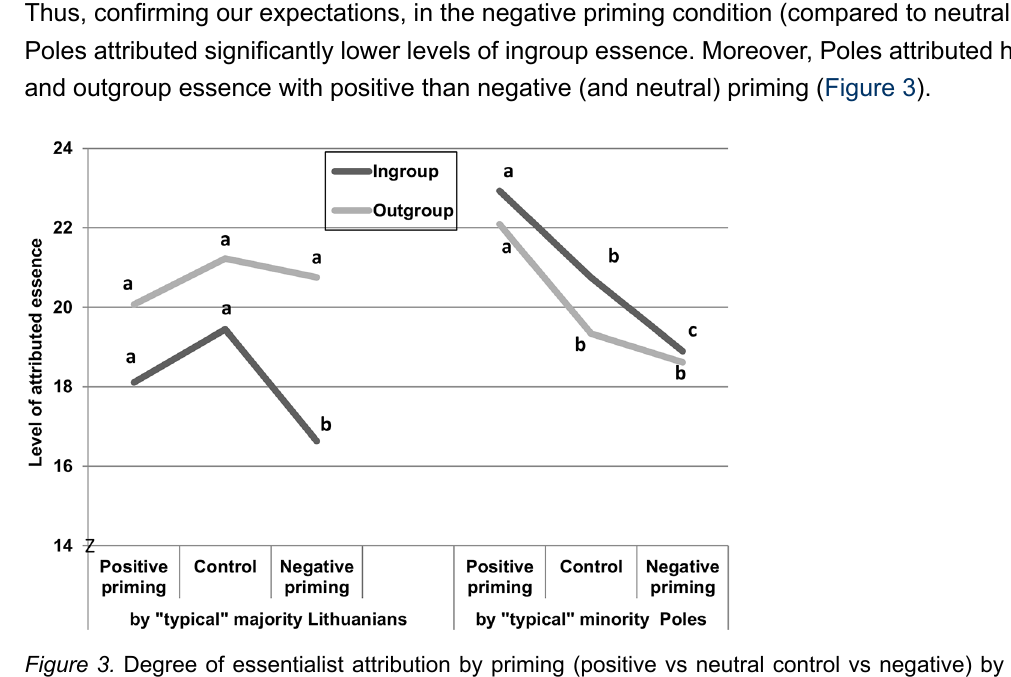
Figure 3. Degree of essentialist attribution by priming (positive vs neutral control vs negative) by group status (Lithuanian majority vs. Polish minority) by target (ingroup vs outgroup). Note. Points with different subscripts are significantly different ( p ≤ .05) within each group's set of ingroup and outgroup